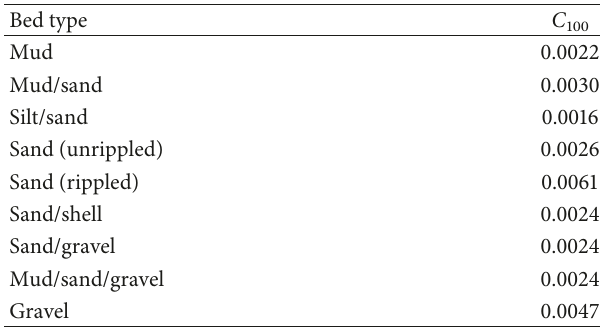
Table 2: Empirically derived values of the drag coefficient (at 1m above the bed) for different bottom types; from Soulsby